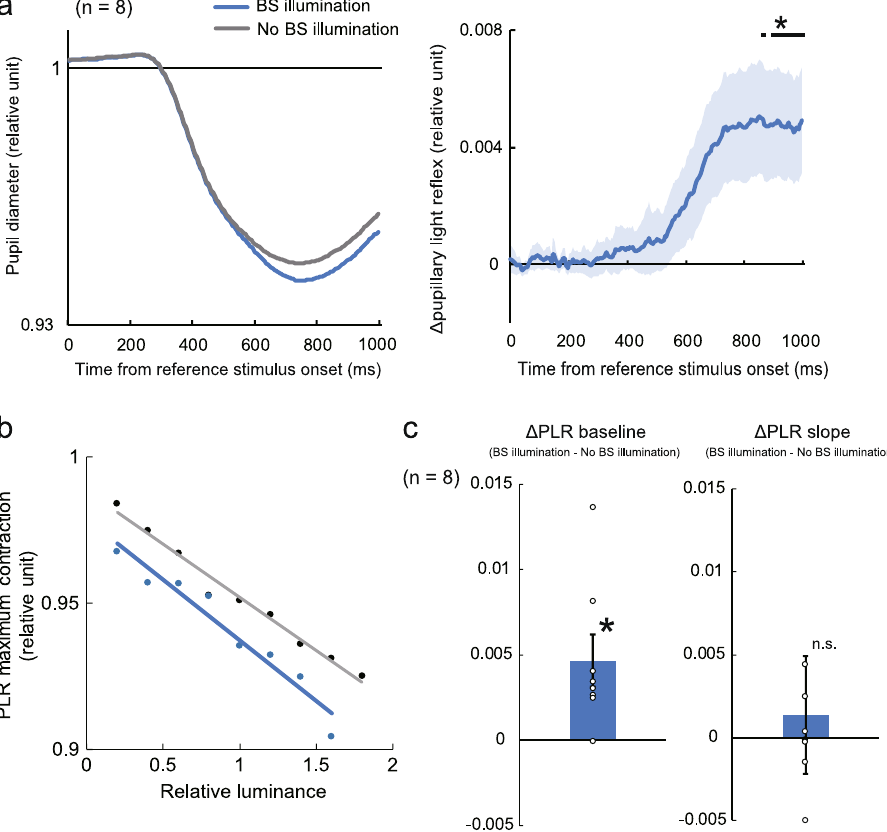
Figure 5. Relationship between brightness perception and enhanced pupillary light reflex (PLR) in the presence of illumination inside the blind spot (BS). ( a ) Left. Average time course (n = 8) of pupil diameter in response to the reference and test arcs with BS illumination (blue) and without BS illumination (black). Right. Average difference (n = 8; mean ± standard error) in pupil diameter between the conditions plotted as a function of time. * p < 0.05 (t-test against zero). ( b ) Amplitude of the maximum pupil contraction as a linear function of the luminance of the reference arc in a representative observer (relative to the test arc luminance, which was fixed at 3.14 cd/m 2 ). ( c ) Differences between the midpoints (left) and between slopes (right) of the linear regression lines for the two conditions (mean ± standard error). * p < 0.05 (t-test against zero).